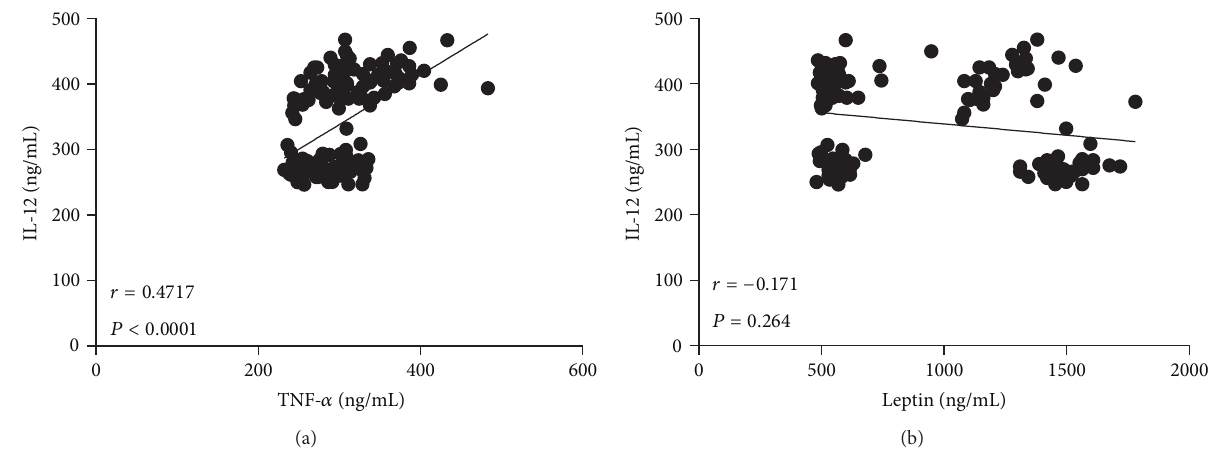
Figure 5: Relationship of the serum levels of IL-12 with systemic low-grade inflammation markers. Serum IL-12 showed a positive significant association with circulating levels of TNF- 𝛼 (a), but not with leptin (b). Coefficients ( r ) and P values were calculated by the Spearman’s correlation model. The correlation level was considered significant when 𝑃 < 0.05